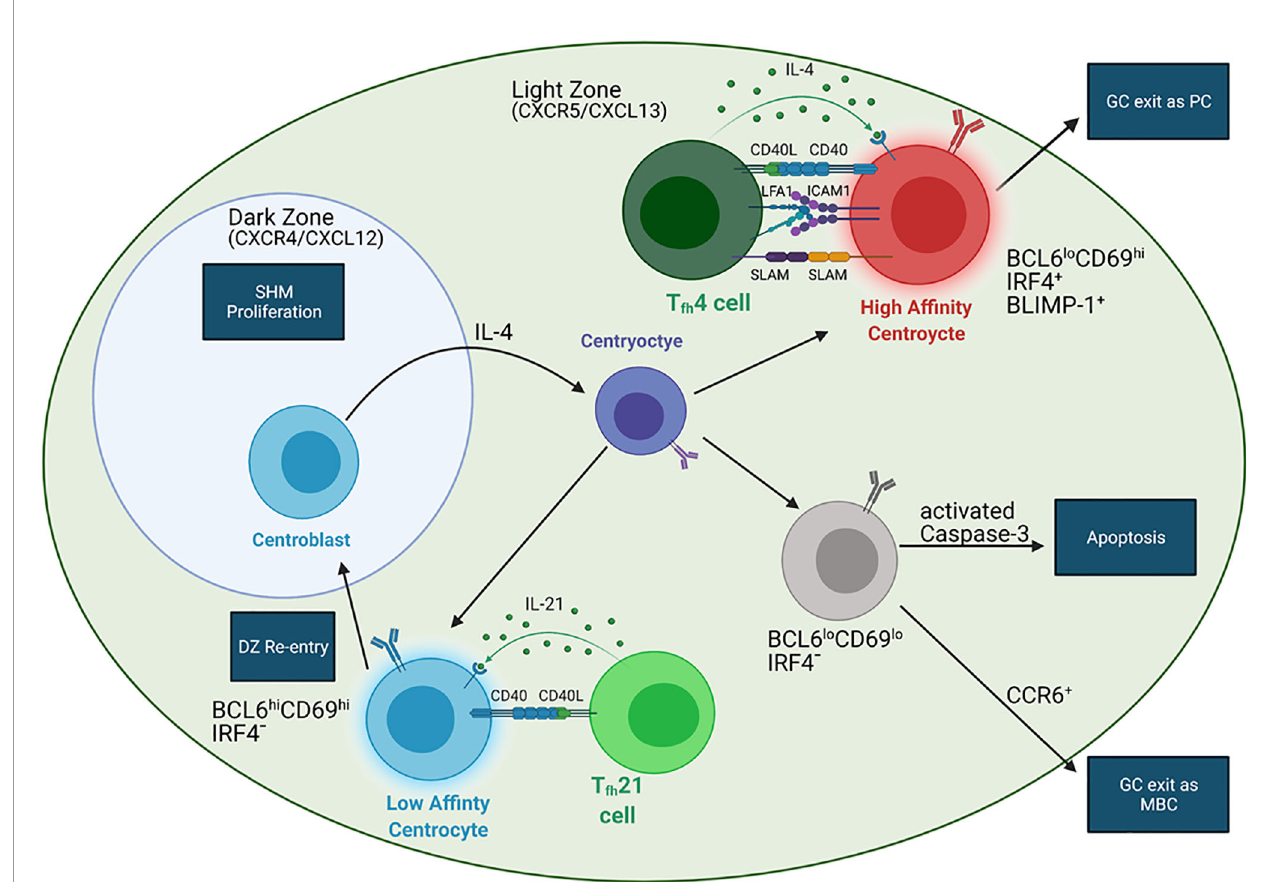
FIGURE 2 | BCR af fi nity controls the fate of GC B cells. In the LZ, B cells with high af fi nity BCRs (red) interact with IL-4 producing Tfh4 cells (dark green) distal to the DZ. IL-4 can induce BLIMP-1 expression in these B cells, leading to GC exit and formation of long-lived plasma cells (LLPCs). These B cells have stronger interactions with Tfh B cells than B cells expressing low af fi nity BCRs due to upregulation of ICAM1 and SLAM. LZ B cells with low af fi nity BCRs (blue) interact with IL-21 secreting Tfh21 cells (light green) more proximal to the DZ. These B cells do not upregulate BLIMP-1 but are converted into centroblasts (blue cell in DZ) via IL-21, allowing for DZ entry and GC recycling. Centroblasts do not express a functional BCR. Migration into the DZ is dependent on CXCR4, which responds to the DZ chemokine CXCL12. When the centroblasts exit the DZ, they convert into centrocytes with varying BCR af fi nities (purple) via IL-4 signaling. The af fi nity of the newly mutated BCR (purple) may or may be increased, which will in fl uence the next step in B cell development. Migration into the LZ depends on CXCR5, which responds to the LZ chemokine CXCL13. Another population of LZ B cells (gray) are relatively quiescent and may be either MBC precursors or an apoptotic population. CCR6 expression indicates MBC precursors while activated caspase-3 expression indicates apoptotic B cells. Additionally, CD40-CD40L interactions are required in all Tfh-B